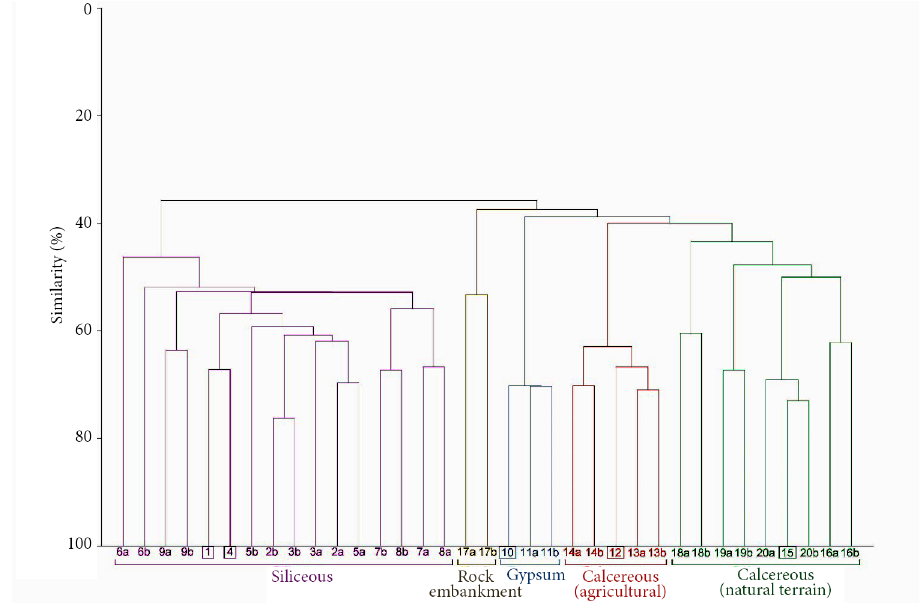
Figure 2. Dendrogram of vegetation relevés. Boxes: surrounding vegetation; a: relevés in 2002; b: relevés in